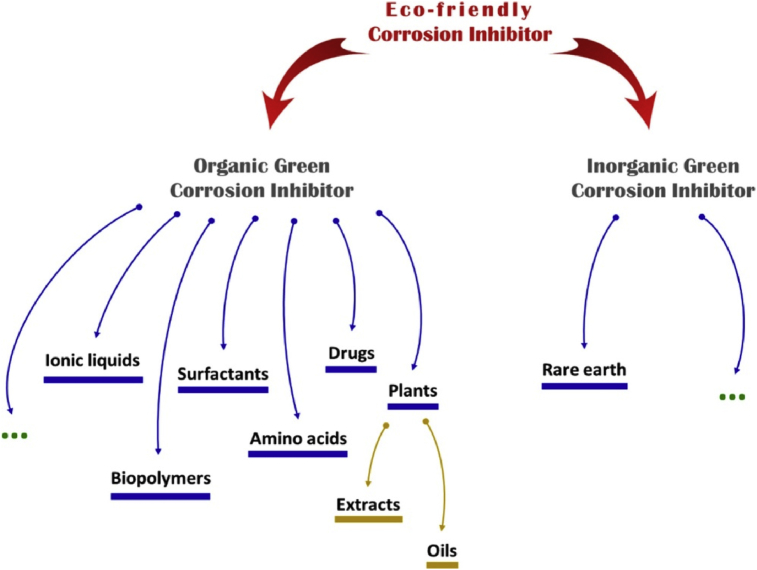
Sources of eco-friendly OGCIs [23].